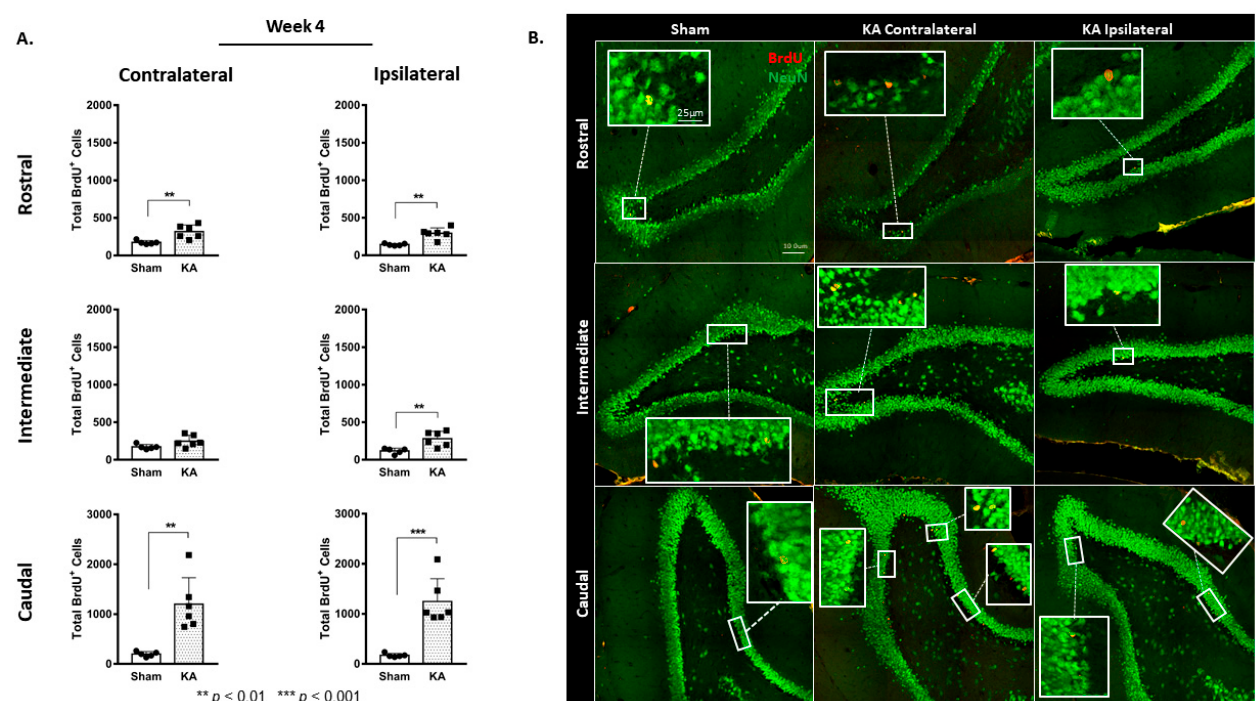
Figure 5. Spatial distribution of neurogenesis showing sustained increase in the ipsilateral and contralateral dentate gyrus at week 4 following continuous micro-perfusion of kainic acid into the AN. ( A ) Total number of BrdU-labeled cells in the rostral, intermediate, and caudal segments of the contralateral and ipsilateral DG in the sham ( n = 5) and KA micro-perfused ( n = 6) rats at week 4. Determination of significance of differences was made using two-tailed unpaired Student’s t -test. ( B ) Confocal images illustrating the distribution of the BrdU-labeled cells in different segments of the DG in the KA micro-perfused (ipsilateral and contralateral sides) and sham rats at week 4. Scale bar is 100 µm.